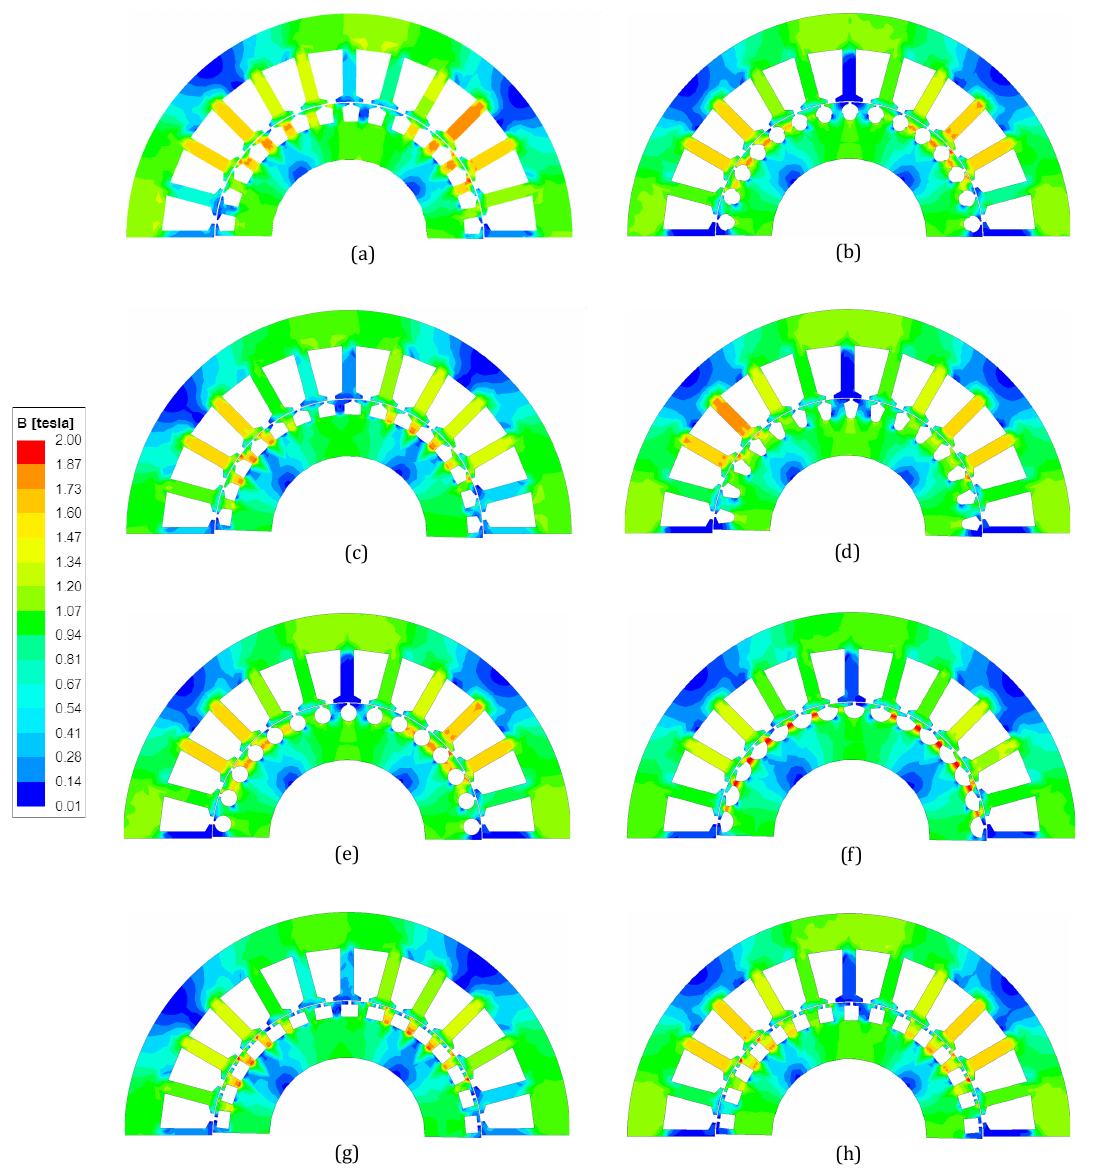
Figure 7. View (½) part and magnetic flux density distribution under nominal operation of the SPIM with C run = 18 µ F and rotor bars of: ( a ) trapezoidal, ( b ) oval, ( c ) pent, ( d ) polygonical, ( e ) round, ( f ) drop, ( g ) rectangular, and ( h ) quadrangular